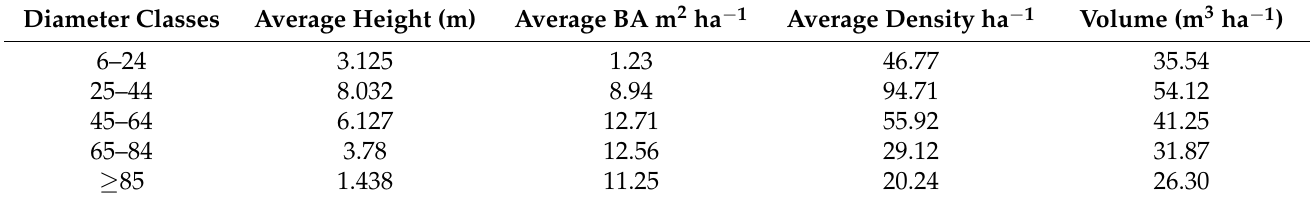
Table 3. Average height, Basal area and density of Monotheca in different diameter classes.